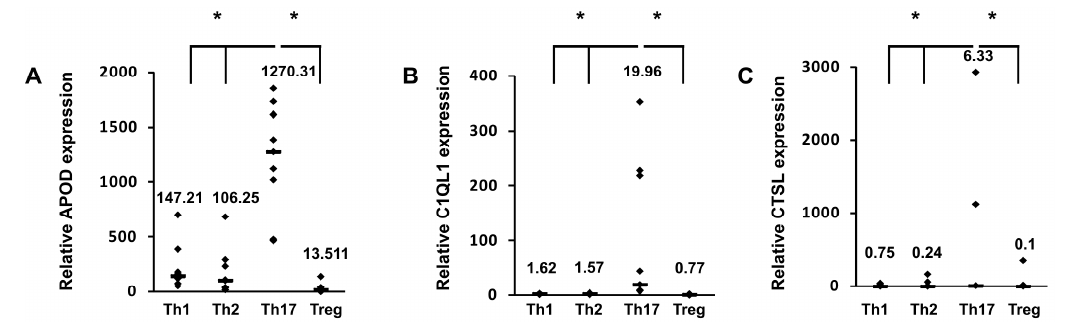
Figure 1. mRNA expression of the APOD ( A ), C1QL1 ( B ), and CTSL ( C ) genes in Th1, Th2, Th17, and Treg cells. The expression of cognate genes was determined by real-time RT-PCR and normalized to that of the housekeeping genes HPRT1 , HMBS and RPL13A . The data are presented as statistical dot plots with the median value (bars) from nine independent experiments performed using cultures from nine different donors ( n = 9). An asterisk indicates a statistically significant difference at p < 0.05. Statistical analysis was performed using Friedman repeated measures ANOVA on ranks followed by Dunn’s post hoc test.